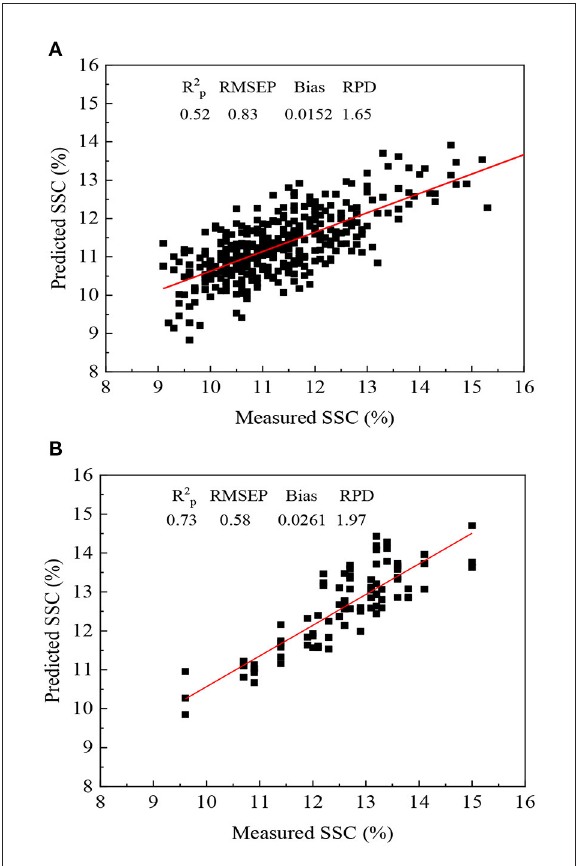
FIGURE6 Prediction results of the PLSR model of SSC after SBC (A) and DOP (B) in predicting populations 7–8 and 10–11 ( n = 360) and populations 5 ( n = 87),